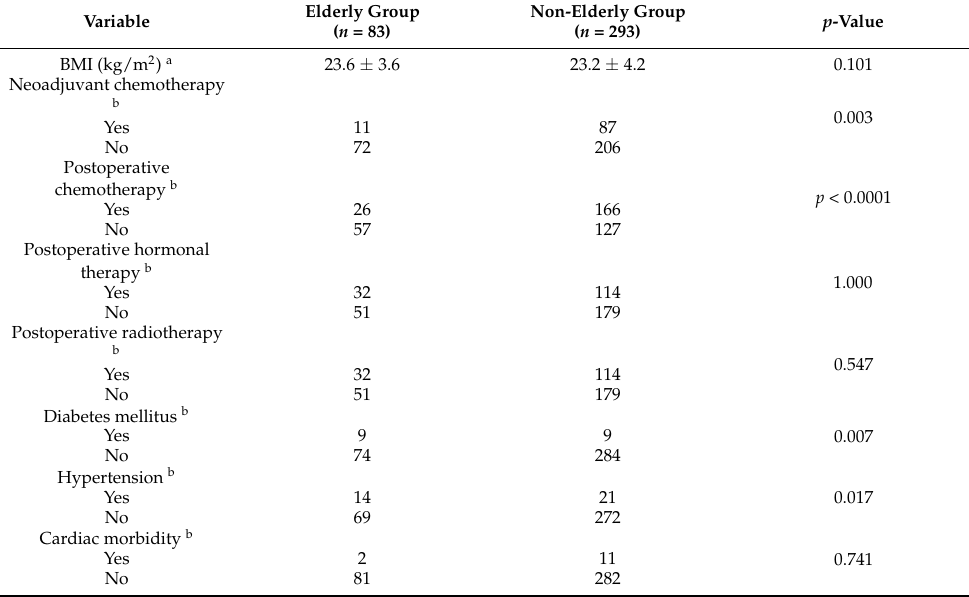
Table 1. Comparison of BMI, treatment, and comorbidity between the elderly and non-elderly groups.